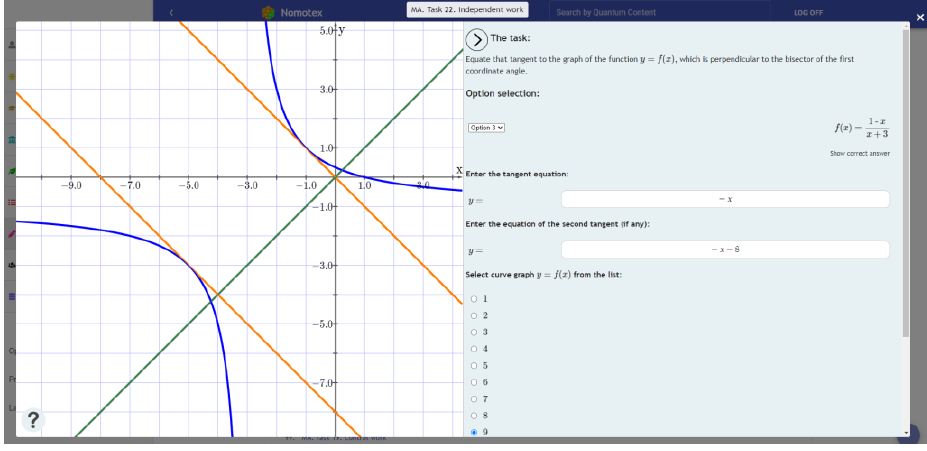
Fig. 7. Graphic problems in the DLS